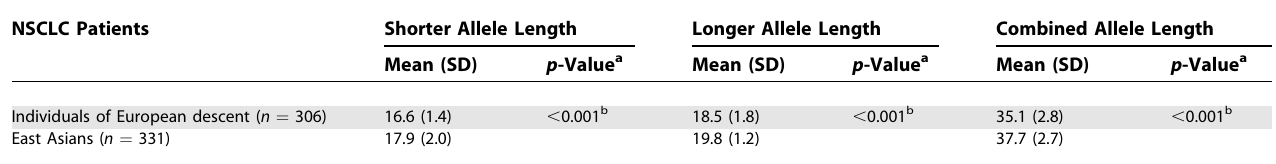
Table 4. Ethnic Differences in Distribution of the Allele Lengths of CA-SSR1 in Lung Cancer Patients NSCLC Patients Shorter Allele Length